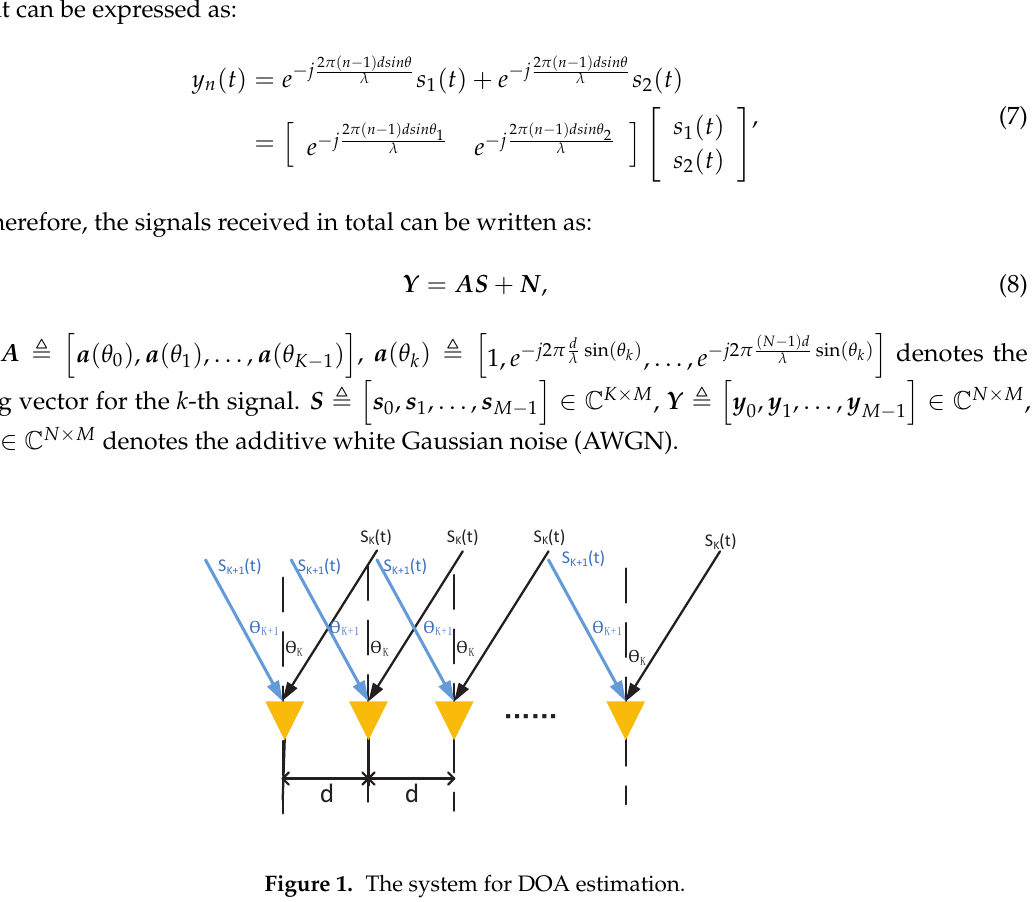
Figure 1. The system for DOA